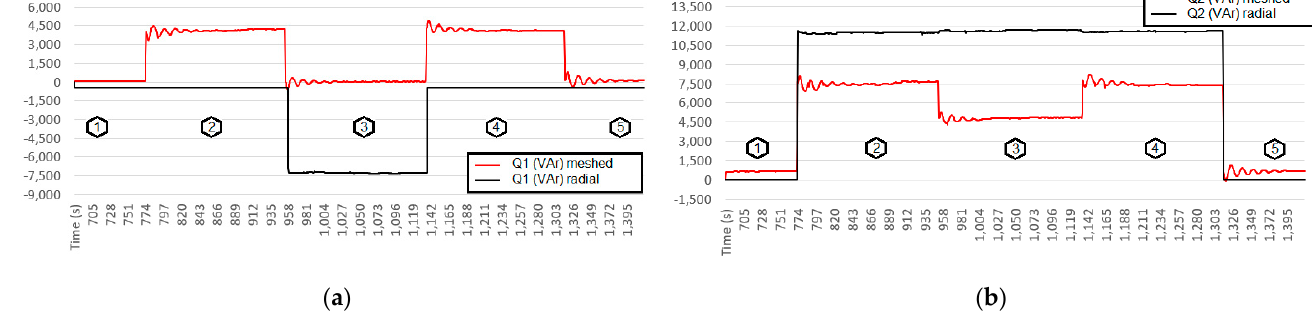
Figure 21. Reactive power delivered by each feeder; ( a ) Q provided by feeder A; ( b ) Q provided by feeder B.